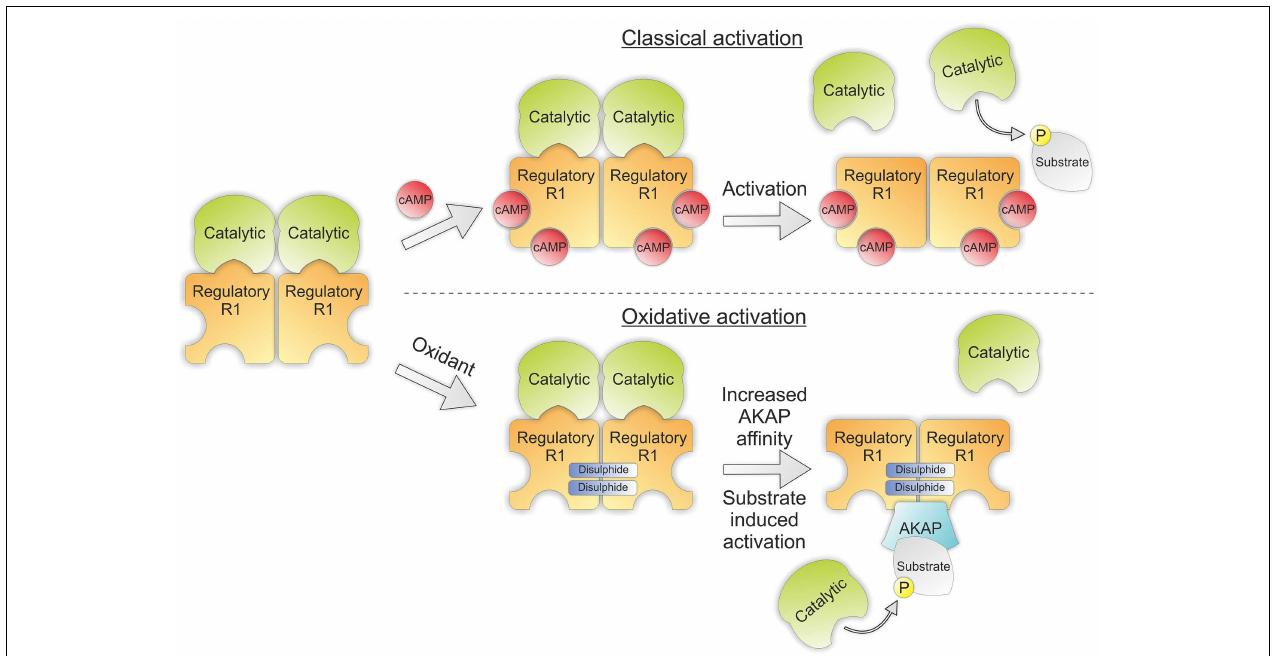
involve the binding of cAMP. Instead two intermolecular disulfides are formed between the regulatory subunits increasing their affinity for their corresponding AKAP. Interaction with their binding partners then brings PKA into proximity with its substrates, thus promoting substrate induced